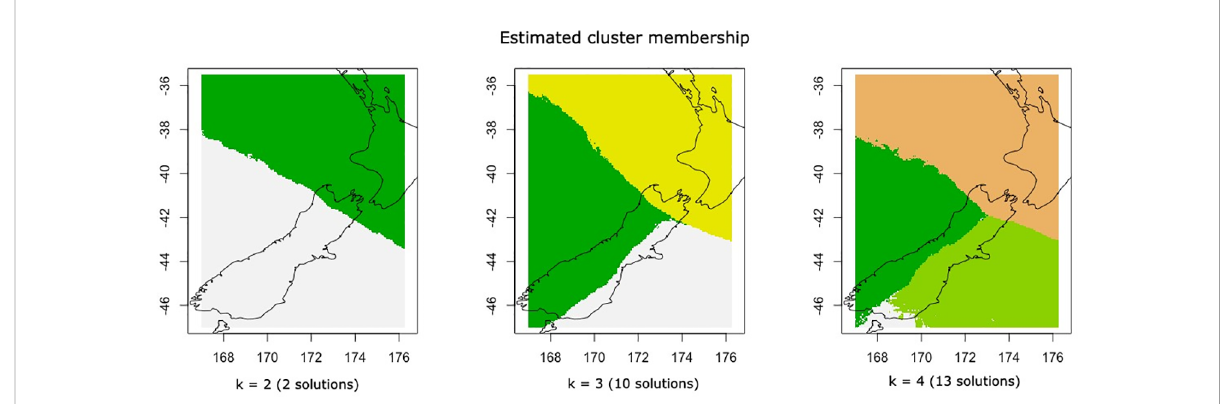
FIGURE 3 Model solutions of genetic structure ( k = number of groups detected) as calculated by Geneland and the number of independent runs (out of 25) that arrived at each